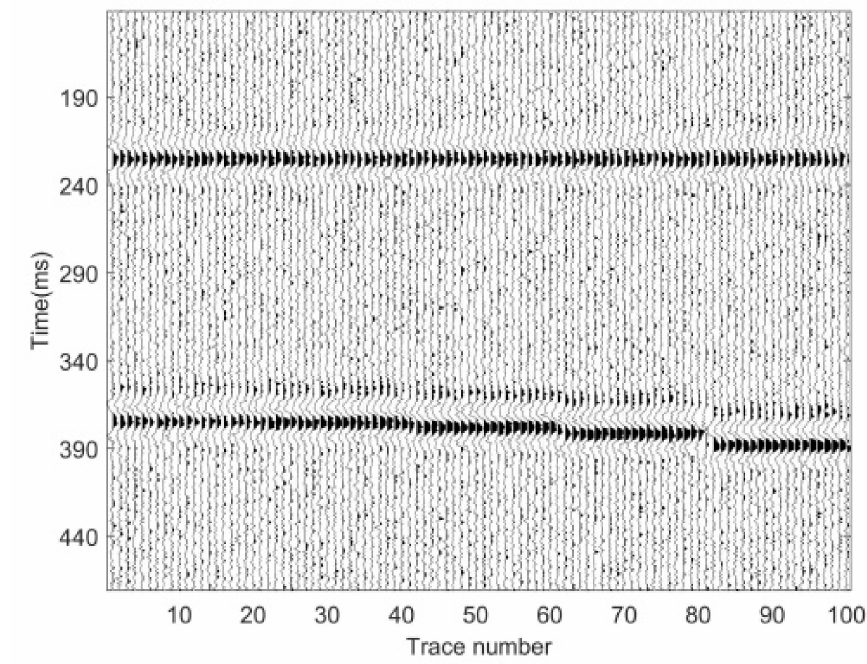
Figure 6. Synthetic seismogram with noise.